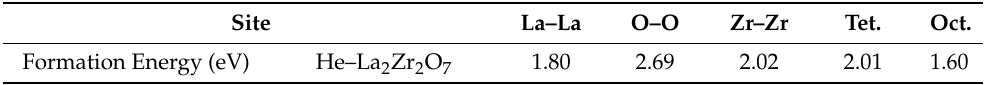
Table 1. Formation energies of helium atom at interstitial